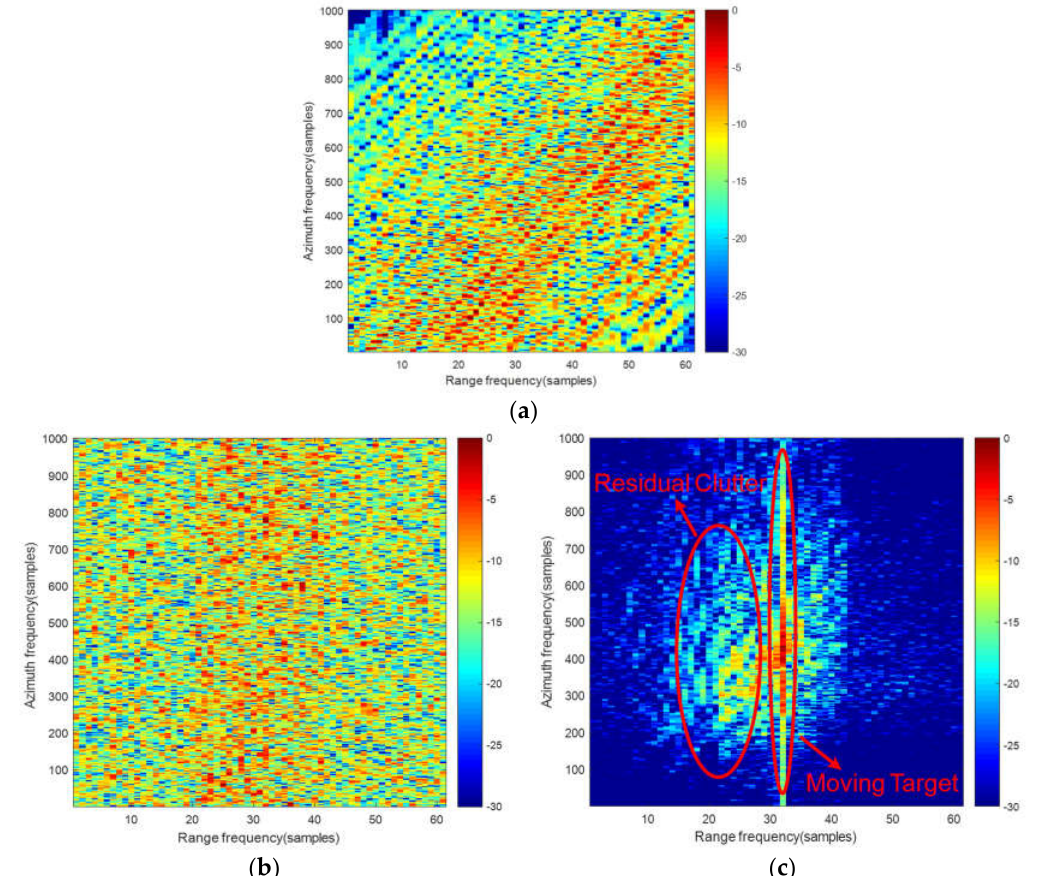
Figure 6. The results of traditional STAP and direct three-channel time-division STACC: ( a ) the echo data after keystone transform; ( b ) The result of traditional STAP; ( c ) The result of direct three-channel time-division STACC.